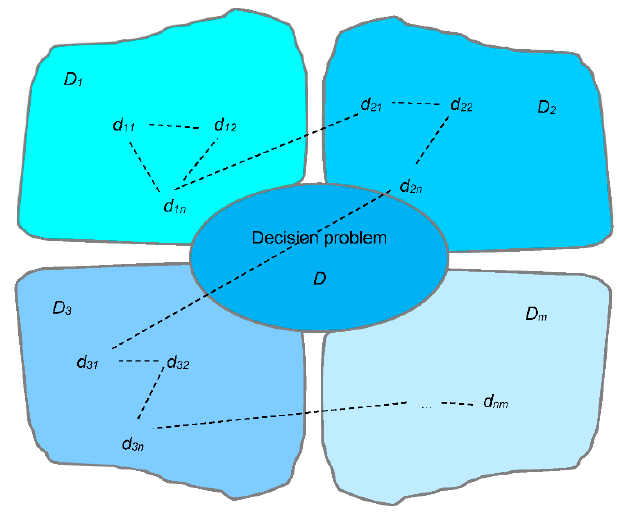
Figure 1. Model of a flat structure decision process.